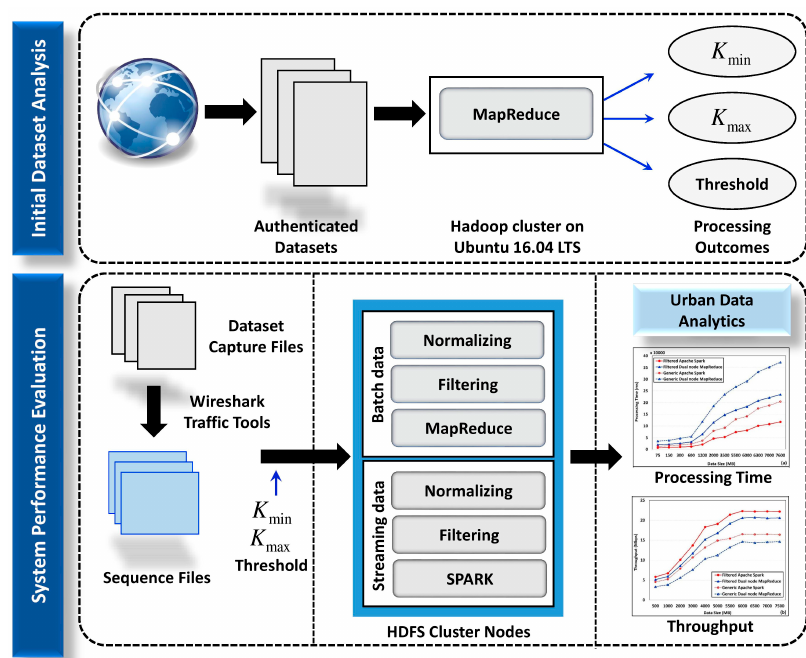
Figure 4. Experimental configuration scenario for initial data analysis and system evaluation.